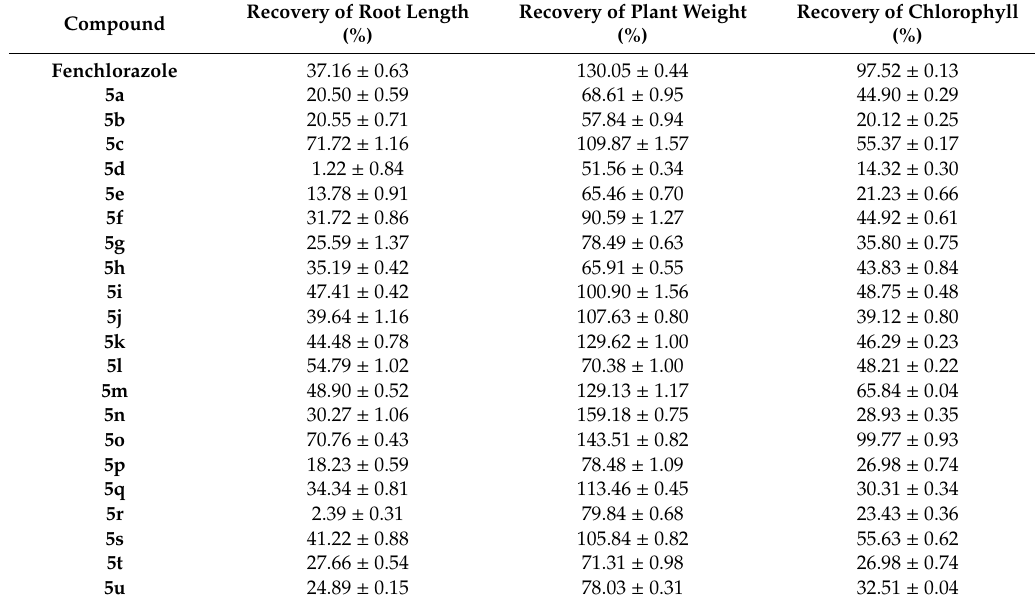
Table 2. Protective e ff ects of compound 5 to wheat